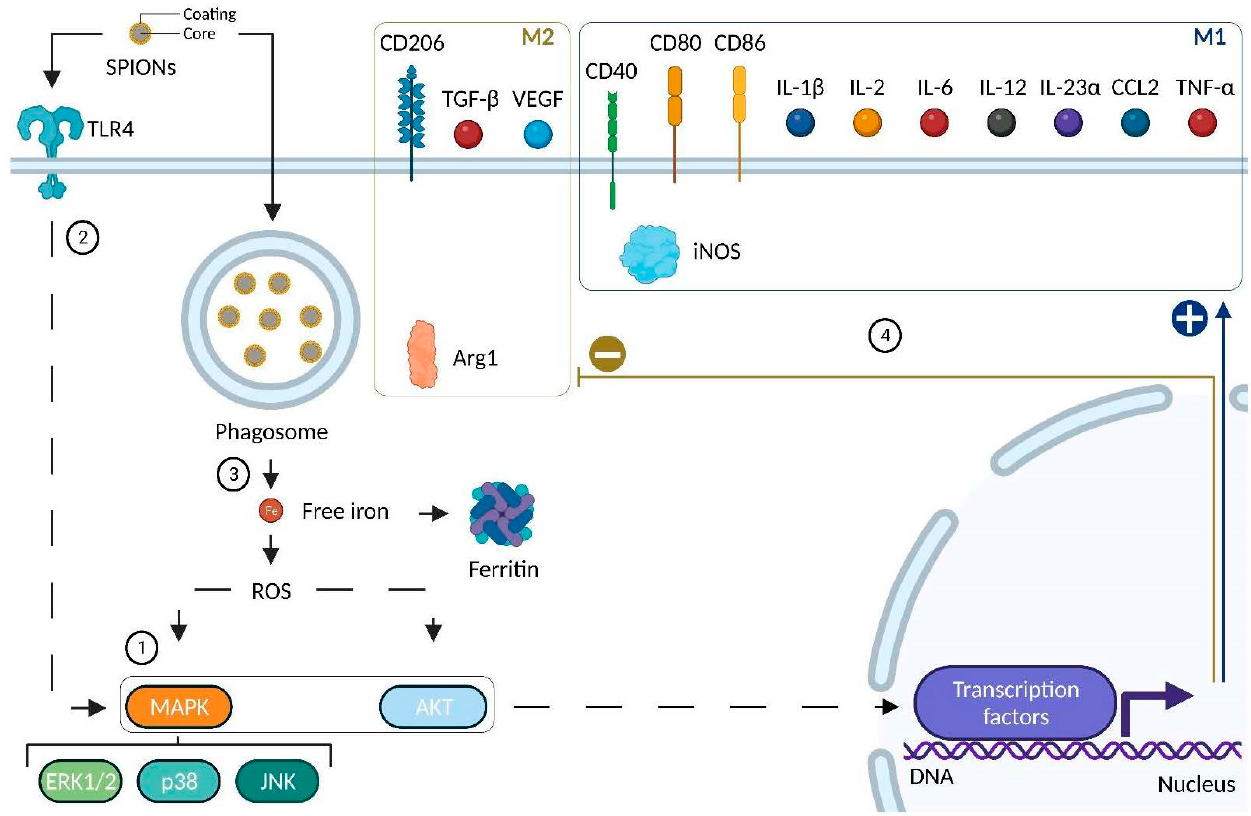
Figure 5. Impact of SPION treatment on polarization markers of macrophages. Created with Bio- Render.com.